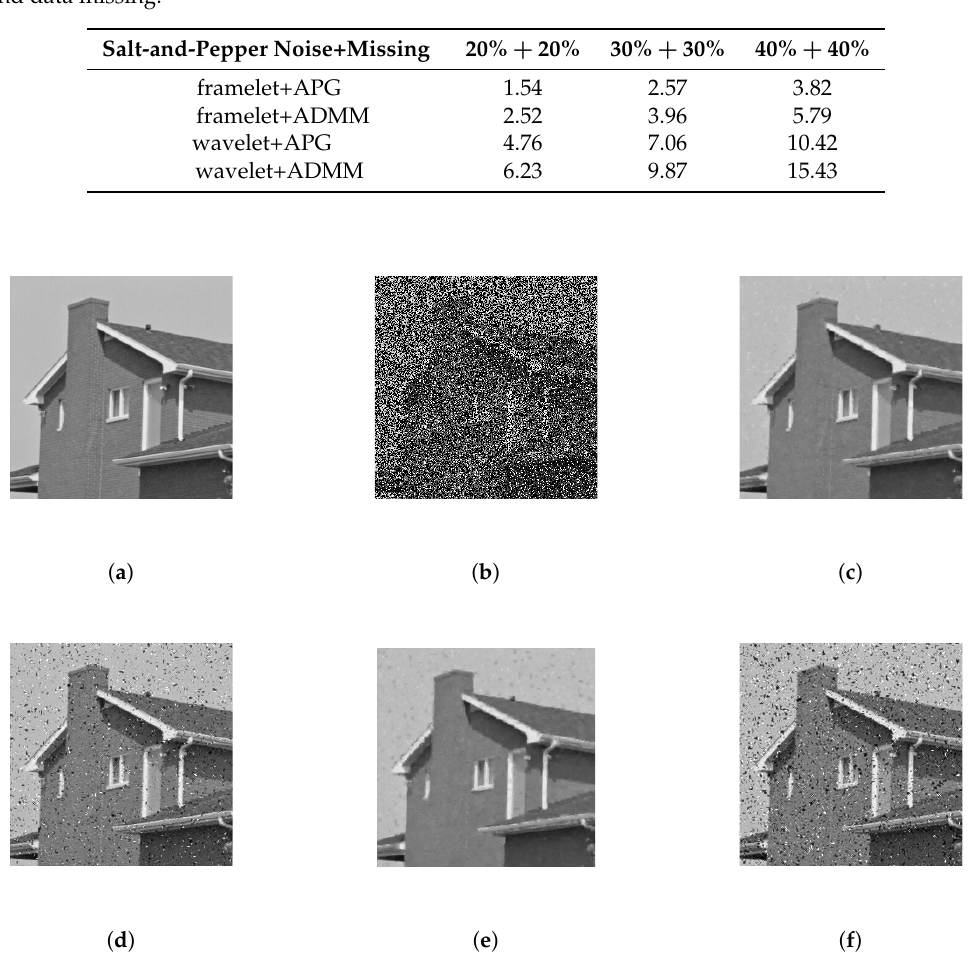
Figure 11. Restoration results of different algorithms under both salt-and-pepper noise and data missing for image house . ( a ) original image; ( b ) corrupted image with 40% salt-and pepper noise and 40% missing (7.51 dB); ( c ) reconstructed image obtained by framelet+APG (31.4 dB); ( d ) reconstructed image obtained by framelet+ADMM (28.6 dB); ( e ) reconstructed image obtained by wavelet+APG (29.1 dB); ( f ) reconstructed image obtained by wavelet+ADMM (26.9